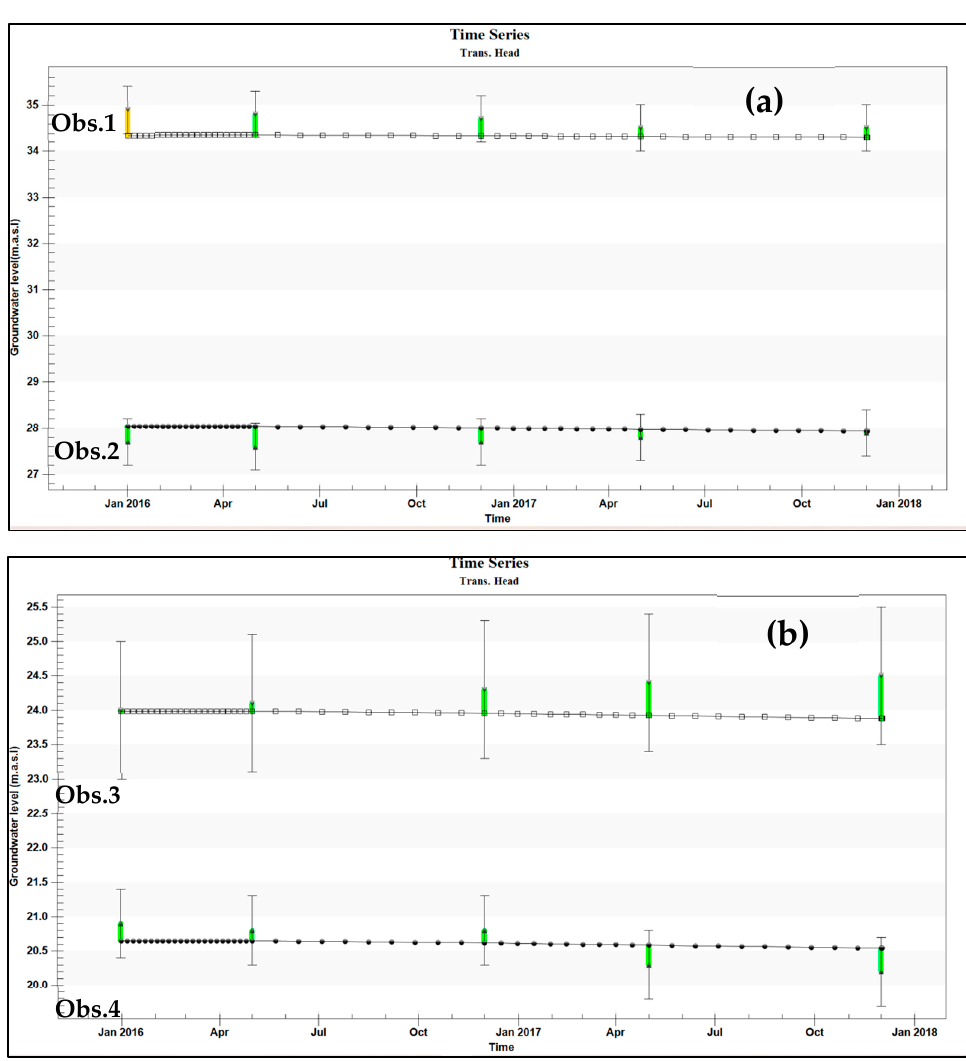
Figure 5. Validation in four observation wells throughout the transient duration 2016 and 2017, ( a ) validation in observation wells 1 and 2, ( b ) validation in observation wells 3 and 4.